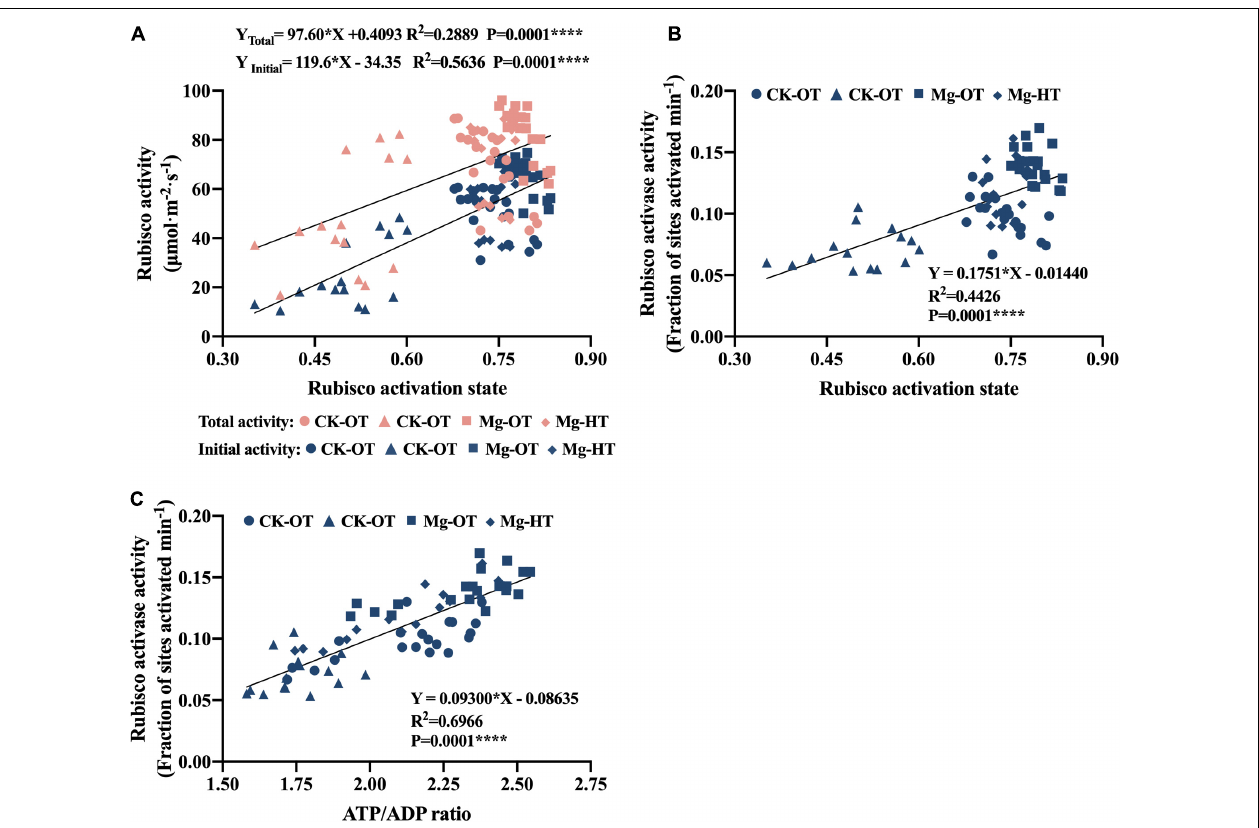
FIGURE 6 | Relationships between Rubisco activities, RCA activity, ATP/ADP ratio, and Rubisco activation state. Values of Rubisco activities, RCA activity, ATP/ADP ratio, and Rubisco activation state are from individual sample values in Figures 3–5 ( n = 70). “ represents Mg-OT, and “ (cid:7) ” represents Mg-HT. The asterisks represent the statistical significance at the P level shown in the figure, respectively. (A) ATP content. (B) ADP content. (C)